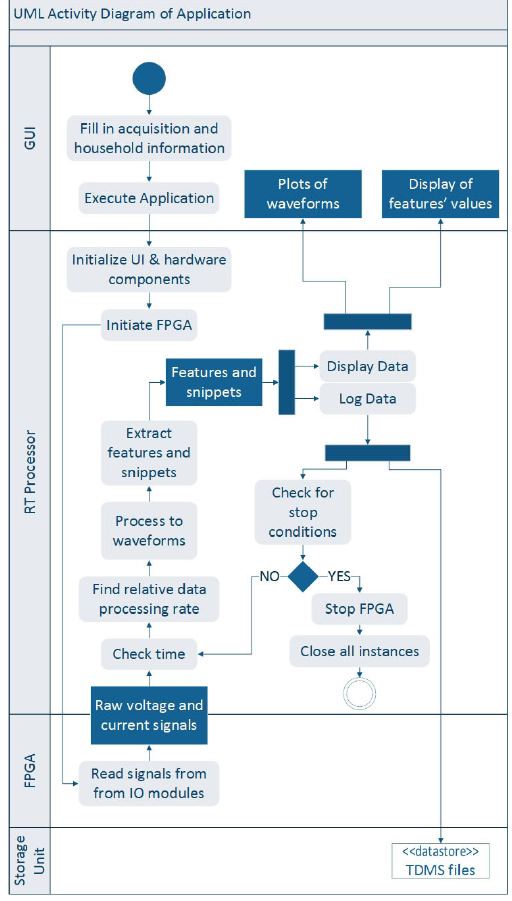
Figure 8. UML activity